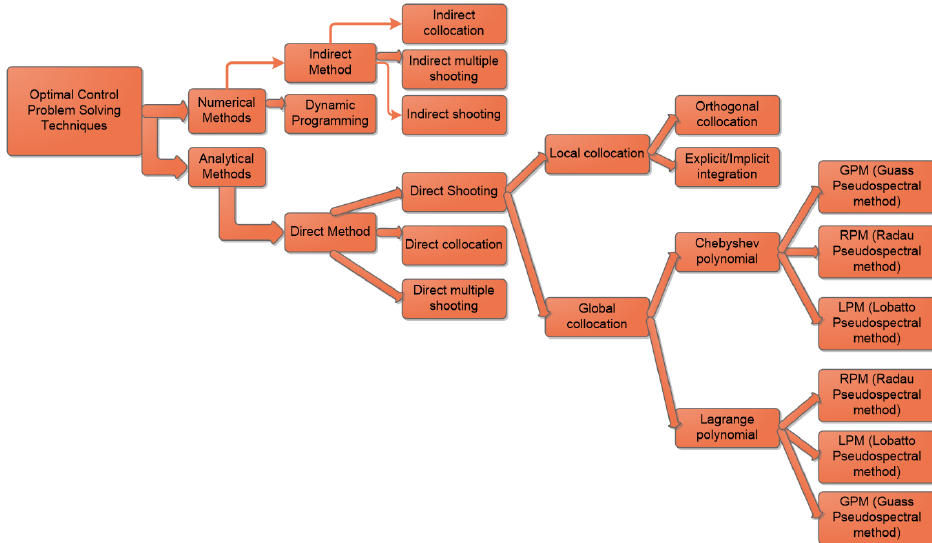
Figure 4. Numerical approaches for the control problem